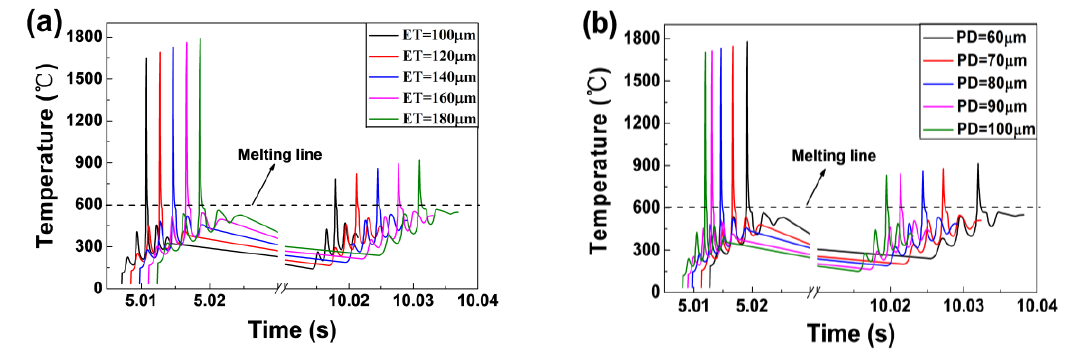
Figure 6. The temperature variation with time at point 2. Using different ET (PD = 80 μm) ( a ) and different PD (ET = 140 μs) ( b ).